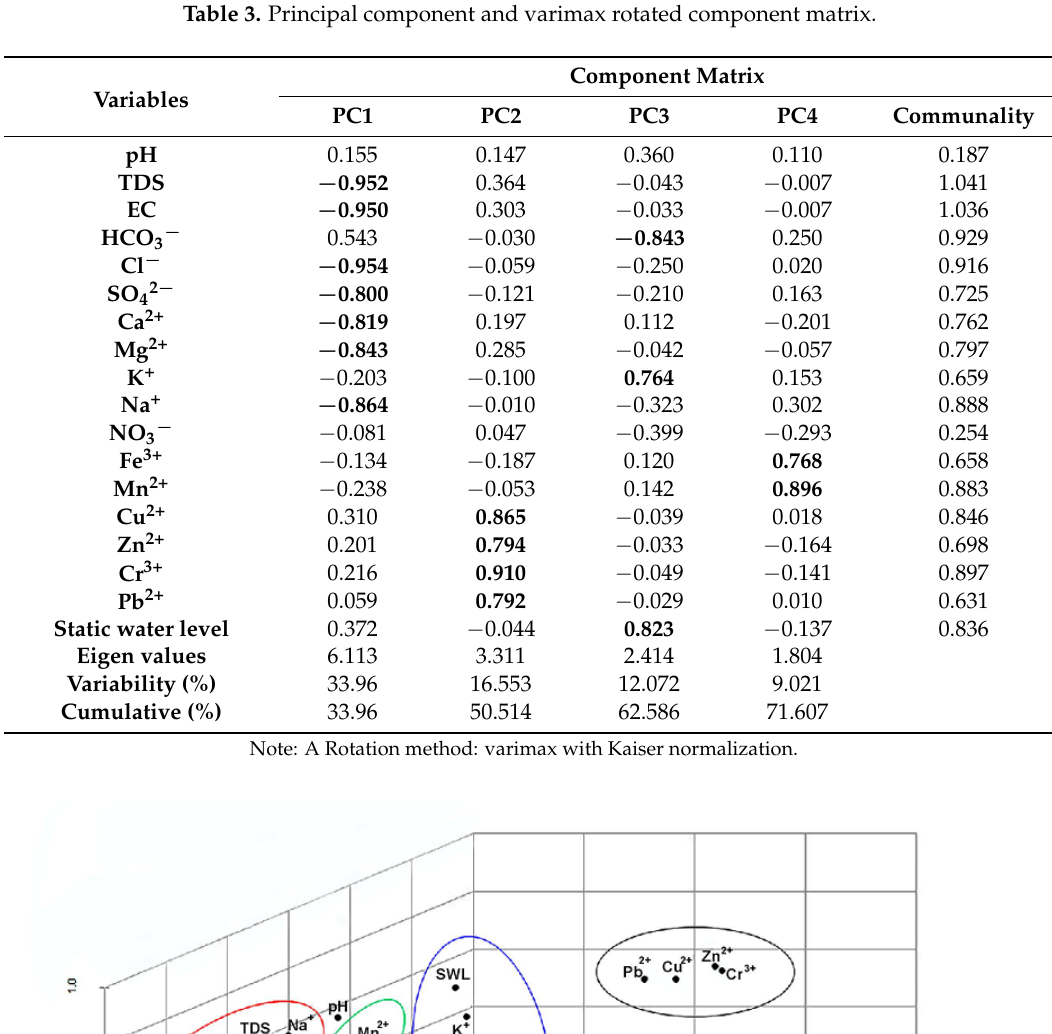
Table 3. Principal component and varimax rotated component matrix.